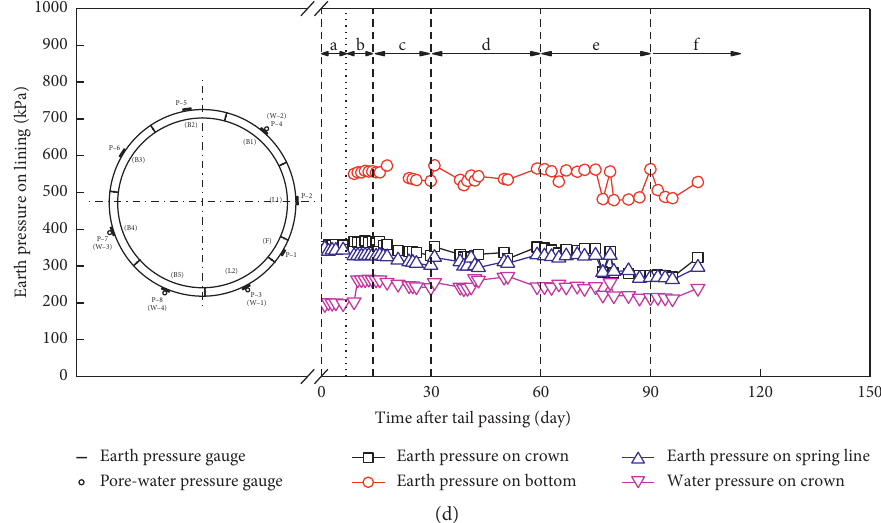
Figure 6: Distribution of earth pressure and water pressure with time: (a) distribution of the earth pressure and water pressure (Section-a, ring 479), (b) distribution of the earth pressure and water pressure (Section-b, ring 1094), (c) distribution of the earth pressure and water pressure (Section-c, ring 1210), and (d) distribution of the earth pressure and water pressure (Section-d, ring